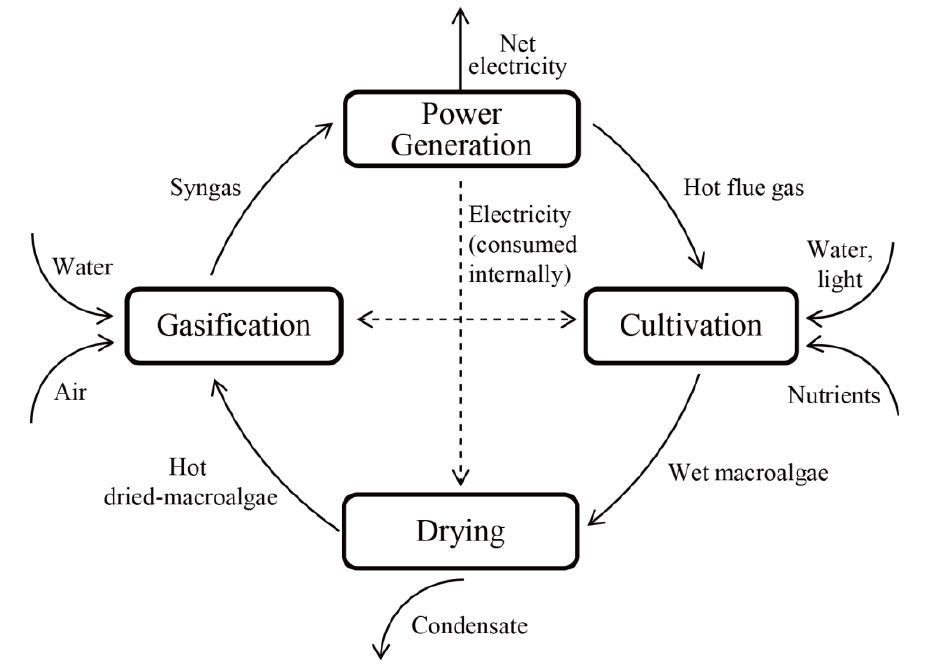
Figure 2. Process flow diagram of the proposed integrated-processes for macroalgae consisting of drying, gasification, and combined